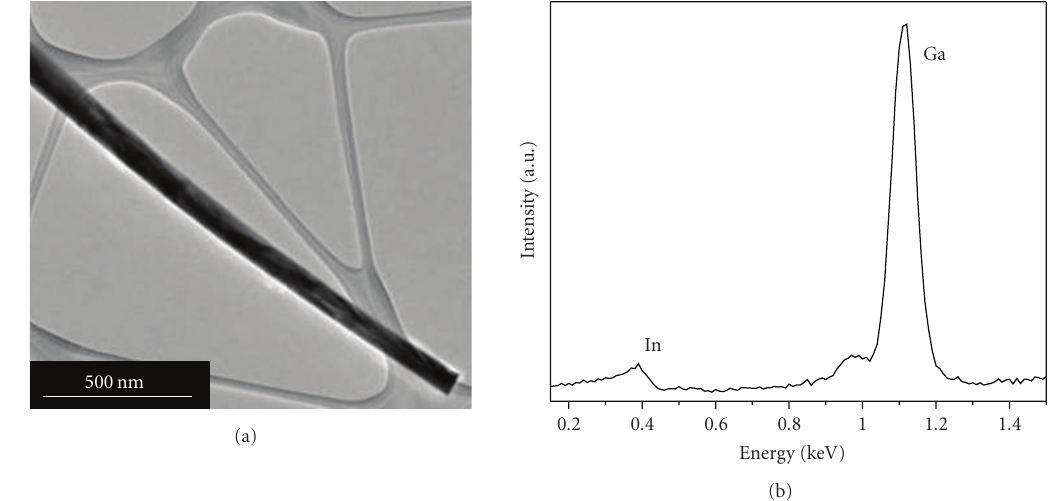
Figure 2: (a) TEM image showing the morphology of the GaN@InGaN core-shell nanowires. (b) Energy dispersive X-ray spectroscopy shows peaks from the In shell and the Ga shell indicating the presence of Indium in the shell of the GaN@InGaN core-shell